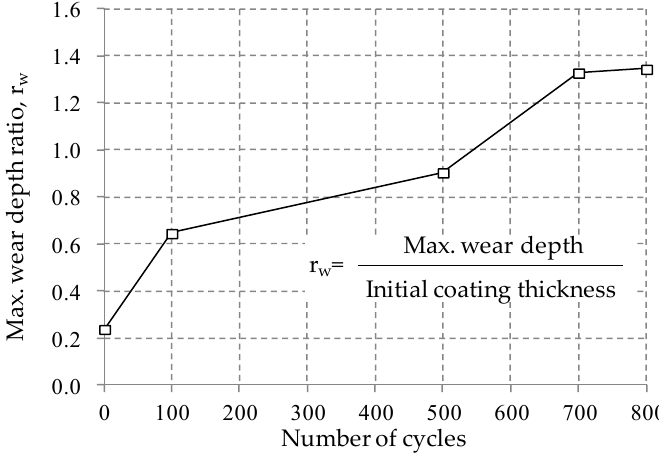
Figure 9. The maximum wear depth evolution according to number of cycles. The maximum wear depth ratio defined as the ratio of the maximum wear depth to initial coating thickness.